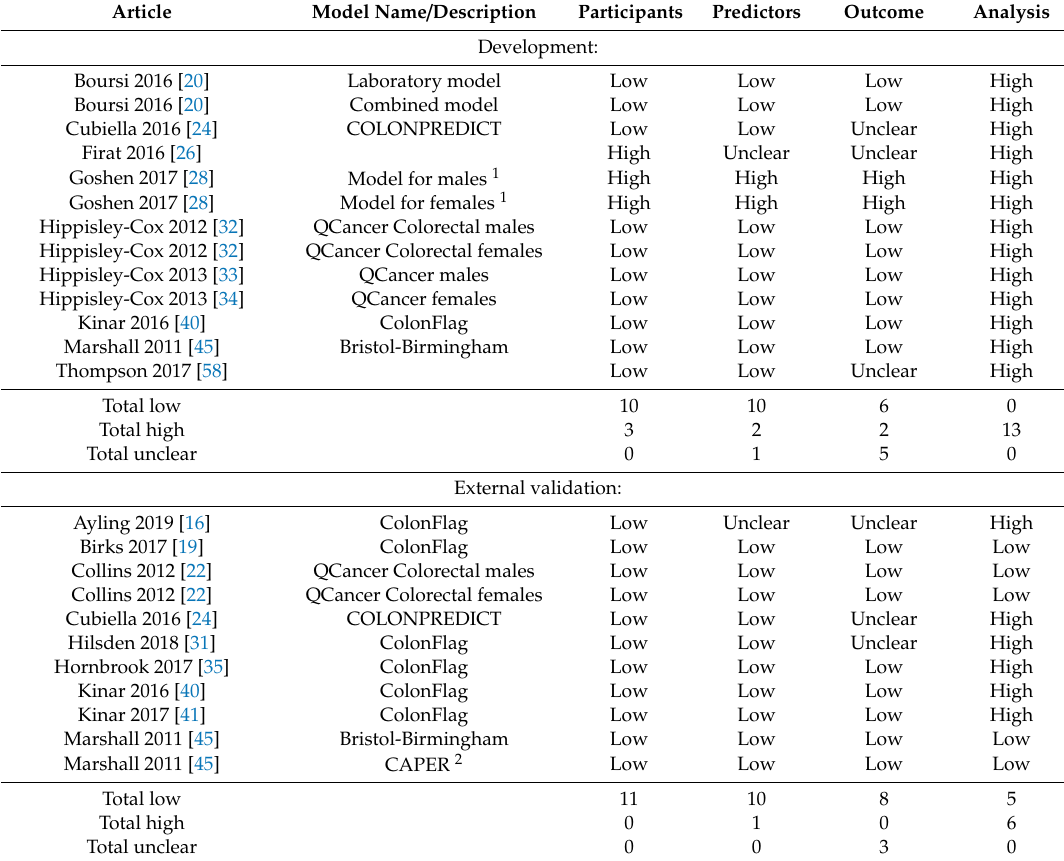
Table 3. Risk of bias in the 16 studies that developed or validated a full blood count-based prediction model ( n = 24) for colorectal cancer diagnosis (Aim 2), assessed using the PROBAST